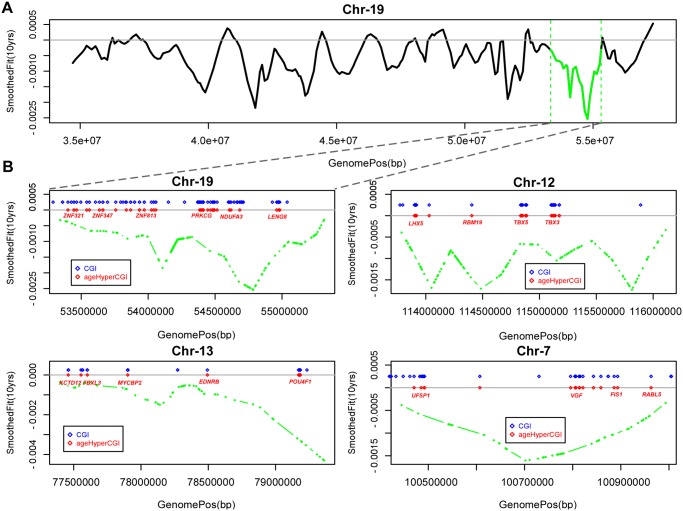
Age-associated hypomethylated blocks enriched for hypermethylated CGIs.
A) Example of a large genomic region on chromosome-19 containing a significant age-associated hypomethylated block (indicated in green). y-axis gives the fit from the Bumphunter algorithm indicating the methylation change for an increase in 10 age-years, x-axis the genomic position. B) Selected age-hypomethylated blocks enriched for CGIs undergoing hypermethylation. Each plot shows the fit from the Bumphunter algorithm indicating the methylation change per 10 age-years (y-axis) as a function of opensea probe position (x-axis). In blue we indicate the positions of CGIs, and in red those that are significantly hypermethylated with age. Some of the genes associated with the age-hypermethylated CGIs are indicated in red.